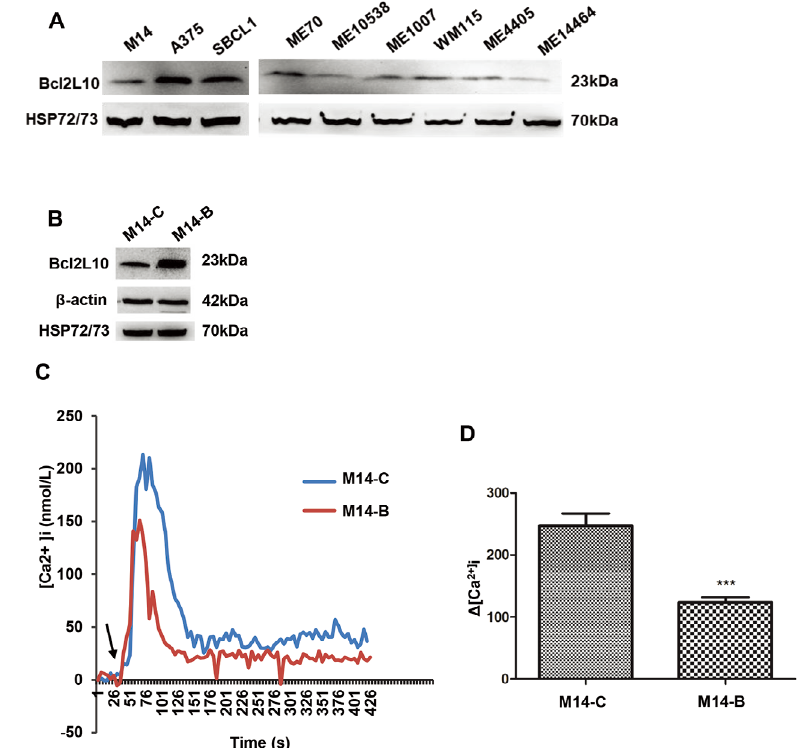
Figure 1. Bcl2L10 is expressed in human melanoma cells and inhibits intracellular calcium release. (A) Western blot analysis of endogenous Bcl2L10 protein expression in human melanoma cell lines (M14, A375, SBCL1, WM115) and patient-derived melanoma cells (ME70, ME10538, ME1007, ME4405, ME14464). (B) Western blot analysis of Bcl2L10 protein expression in M14 cells stably overexpressing Bcl2L10 (M14-B) obtained by transfecting M14 parental cells with the plasmid expressing the full length human Bcl2L10 protein fused to the N-terminal Myc epitope tag. Empty vector was used to obtain the control clone (M14-C). Reported images are representative of at least two (A) or three (B) independent experiments with similar results. β-actin and HSP72/73 were used to check equal loading and transfer. (C, D) Live imaging in single FURA-2-AM loaded M14-C and M14-B cells. [Ca 2+ ] were measured after stimulation with histamine. Calcium levels changes are reported as (C) i representative traces and (D) as maximum Ca 2+ concentrations in bar charts. Arrow indicates time of histamine addition. Data were expressed as average ± standard deviation of three independent experiments. n = 30–45 cells/experiment. Statistical analysis was performed applying t test. *** P <